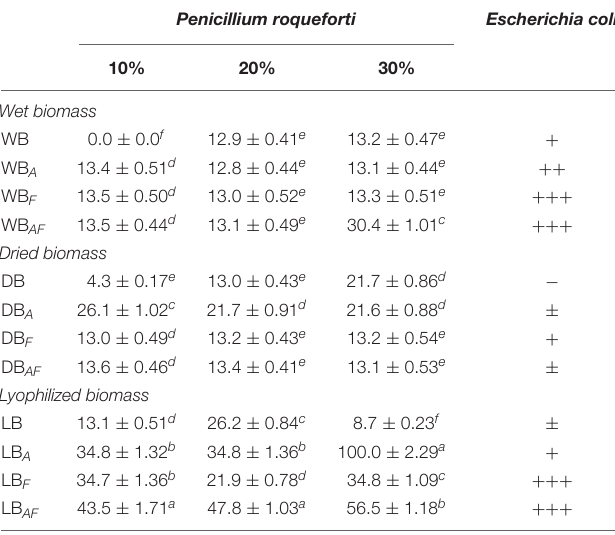
TABLE 3 | Antimicrobial activity of wet (WB), dried at low temperature (DB), and lyophilized (LB) Spirulina biomasses. Penicillium roqueforti